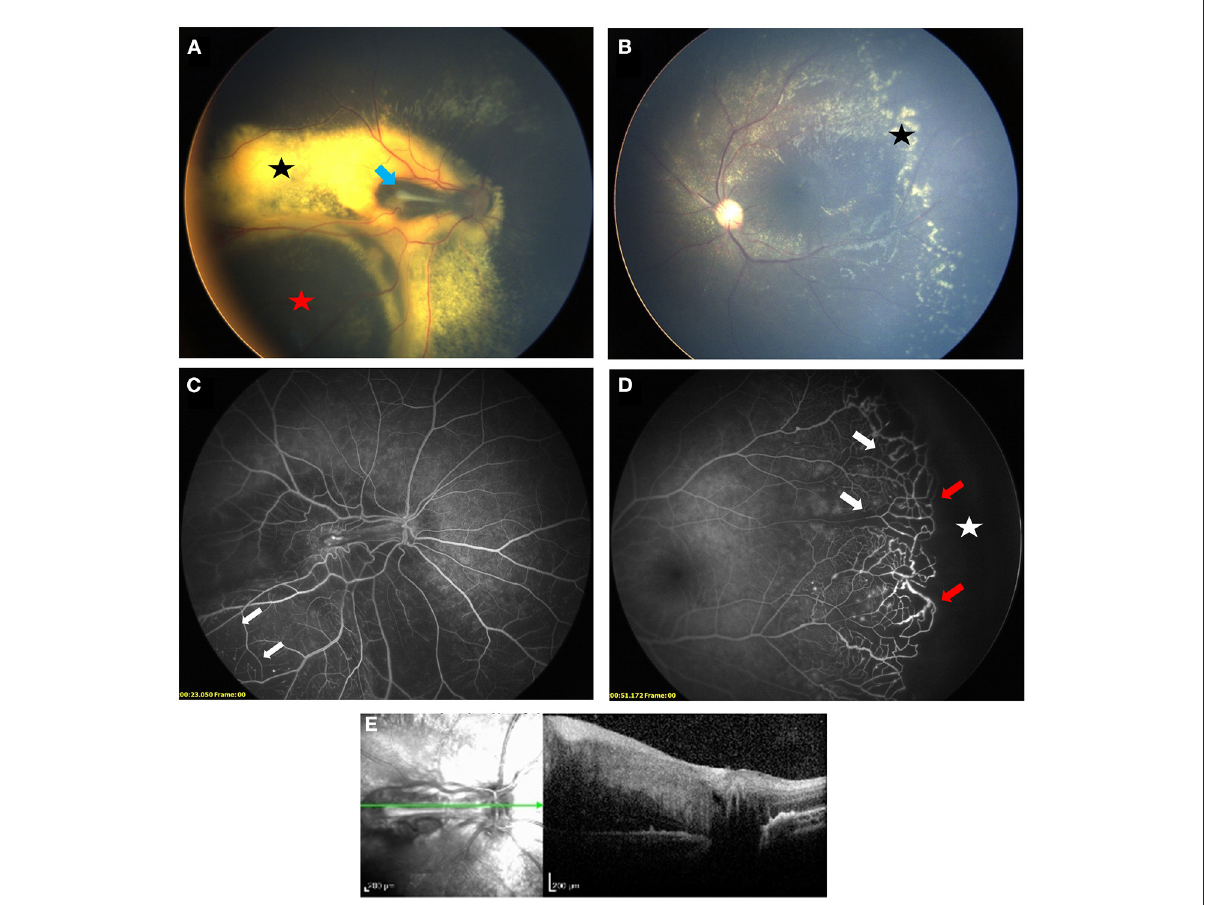
FIGURE1 Bilateral Coats’ disease in a 3-year-old girl. Right eye (A) is stage 3A1: fundus photograph shows an extrafoveal retinal detachment (red star) with exudates (black star) and a retinal fold at the level of the macula (blue arrow). Left eye (B) is stage 2A with extrafoveal exudation (black star). Fluorescein angiography shows capillary dropout (white arrows) in both eyes (C) right eye, (D) left eye) and a peripheral avascular retina (white star) lined with telangiectasia (red arrow) in the left eye. (E) SD-OCT section showing a thickening and hyperreflectivity of all retinal layers with preretinal fibrosis on top of the retinal